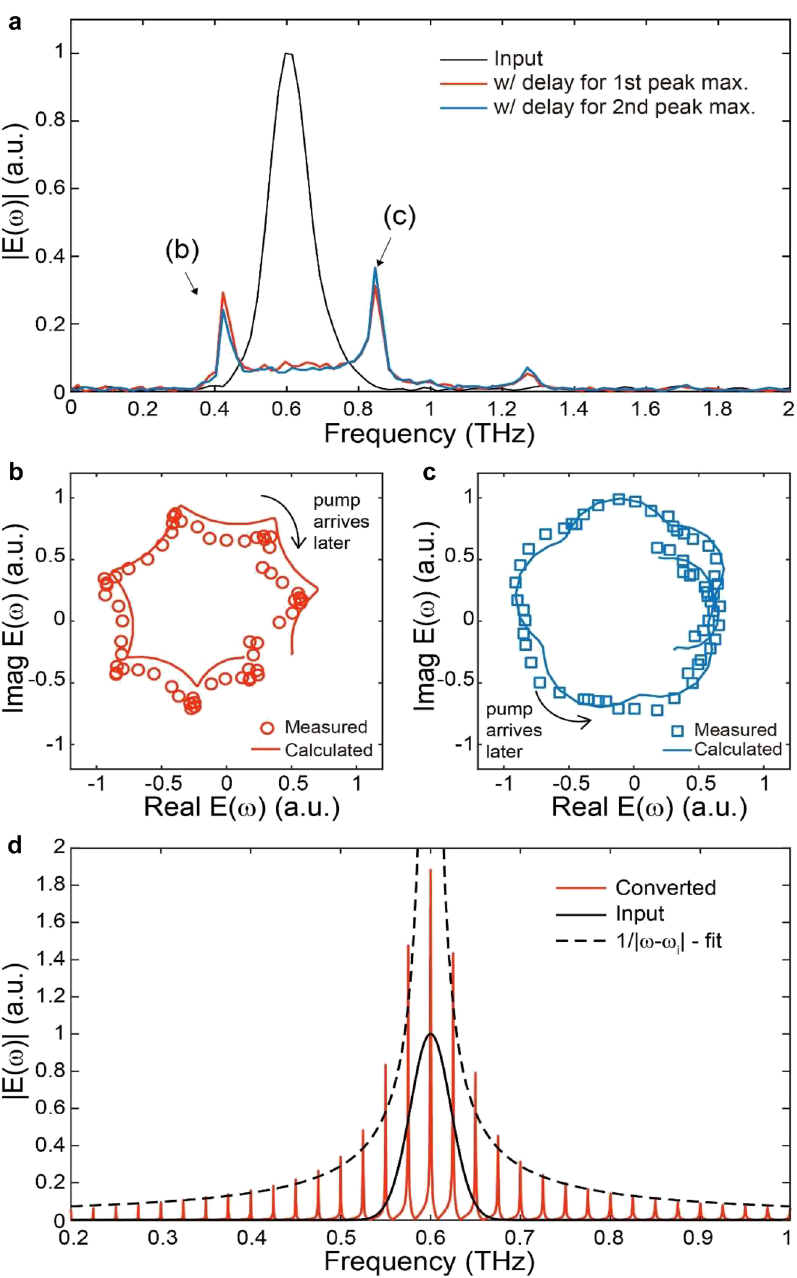
Figure 4: Resonance-enhanced spectral conversion with a multicycle input pulse. (a) Measured spectral amplitudes transmitted through the FP resonator with pump delays optimized for maximizing the component funneled to the fundamental (red line) and second-order (blue line) resonancefrequencies.Inthesemeasurements,amulticycleinputpulseislaunchedintotheFPresonator.(b)Complexamplitudetrajectoryof the funneled component at 0.42 THz plotted as a function of the pump delay. Measured complex amplitudes are drawn with red circles, while the calculated complex amplitudes are drawn with a red line. Note that the funneled frequency is lower than the peak frequency of the input THzpulse.(c)Complexamplitudetrajectoryofthefunneledcomponentat0.85THzplottedasafunctionofthepumpdelay.Measuredcomplex amplitudesaredrawnwithbluesquares,whilethecalculatedcomplexamplitudesaredrawnwithablueline.Notethatthefunneledfrequency is higherthan thepeak frequencyof the input THzpulse. (d)Calculatedspectral amplitudes(drawnwith a red line)transmitted throughthe FP resonator with a cavity length of 6 mm. The spectral amplitude of the input THz pulse is drawn with a black line along with a fi tting line | ω − ω | − 1 . Here, ω i i denotes the center (angular) frequency of the input